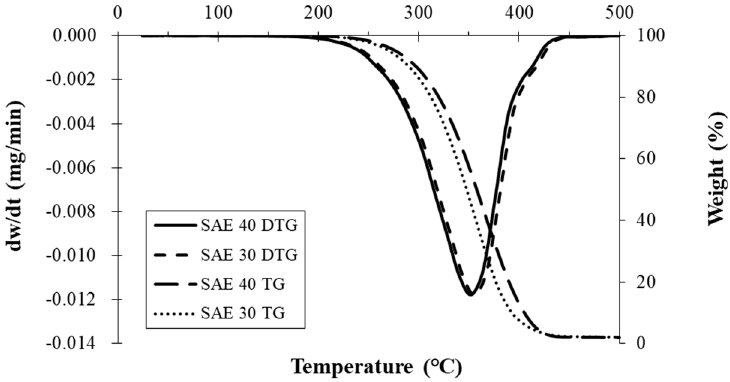
Figure 6. Thermogravimetric analysis (TGA) and derivative thermogravimetric (DTG) profiles of SAE 40 and SAE 30 lubricants.